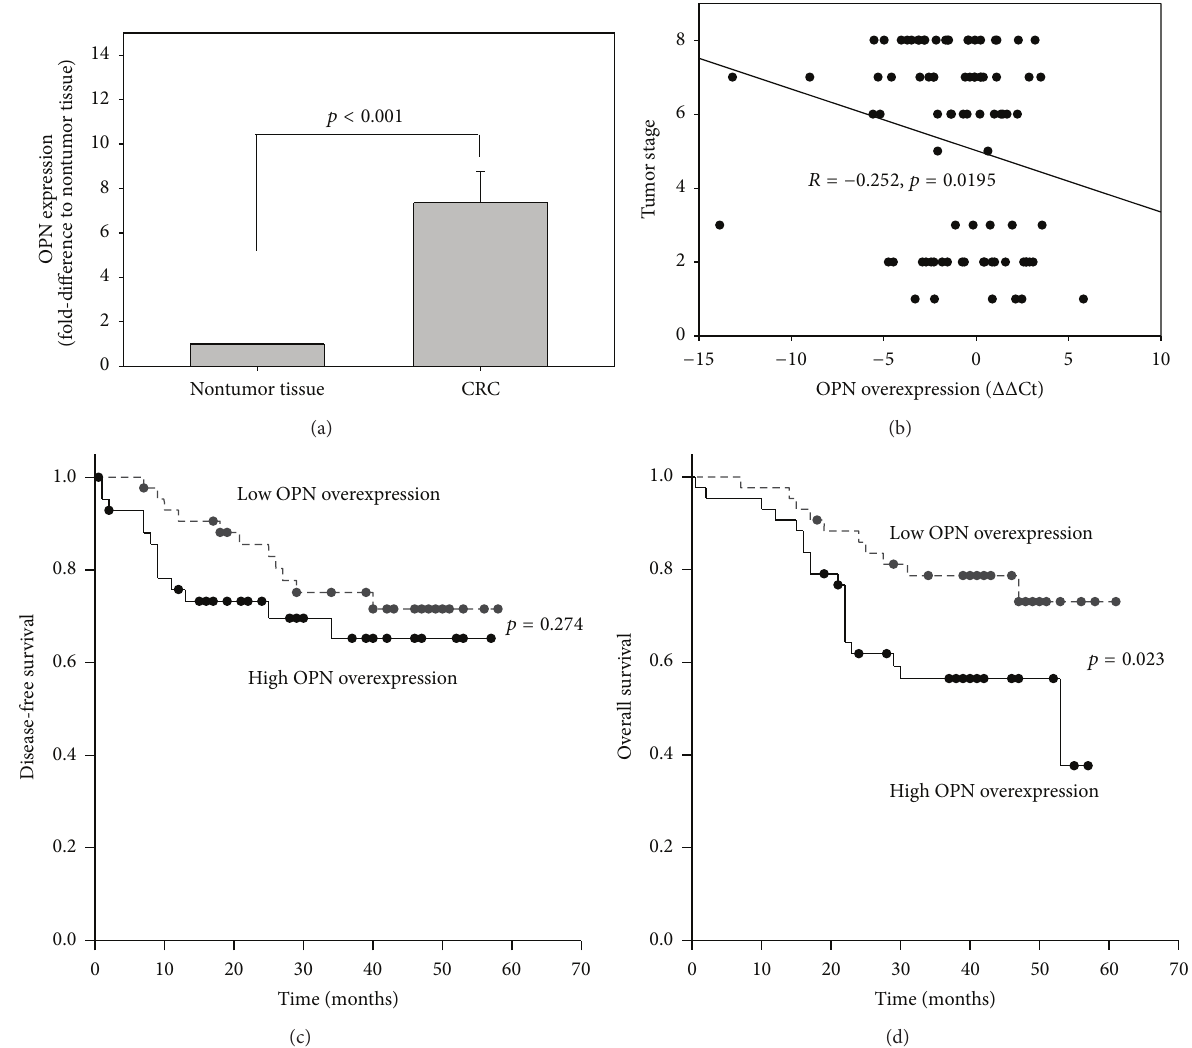
Figure 1: (a) Relative transcript expression of OPN (expressed as fold change to the adjacent nontumor tissue using the 2 −ΔΔ Ct method) of 84 patients; correlation of OPN overexpression (expressed as ΔΔ Ct ( Δ Ct of CRC −Δ Ct of nontumor)) with (b) tumor stage, (c) disease-free survival, and (d) overall survival of CRC